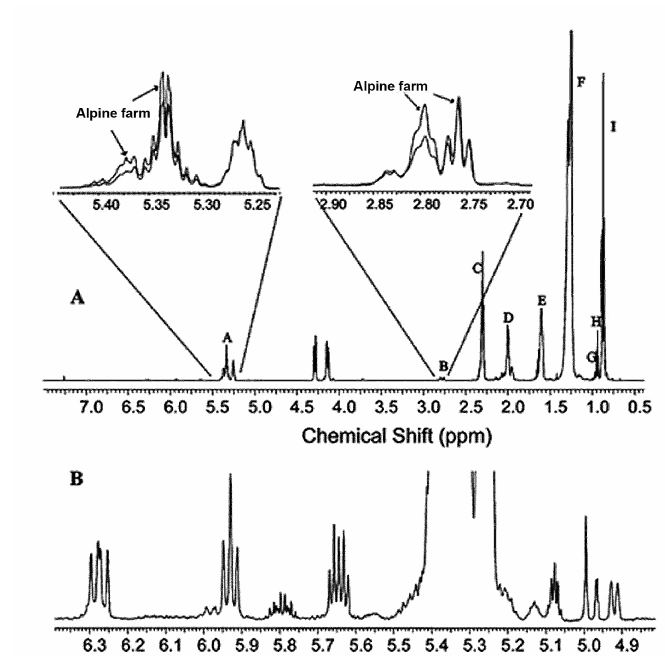
Figure 36. 600 MHz 1 H-NMR spectra of: ( A ) an organic lipid fraction of an Asiago cheese from an alpine farm with the assignment of the major components (A, olefinic protons of all unsaturated chains; B, bis-allylic protons; C, methylenic protons bonded to C2 of all fatty acid chains; D, allylic protons; E, methylenic protons bonded to C3; F, methylenic protons; G, methyl protons of linolenic acid; H, methyl protons of butyric acid; I, all other methyl protons. The insets illustrate a comparison of the lipid fraction of an alpine farm and an industrial factory. ( B ) Expansion of a region in which some important olefinic resonances from CLA are illustrated. Adopted, with permission, from [189]. Copyright 2008, American Chemical